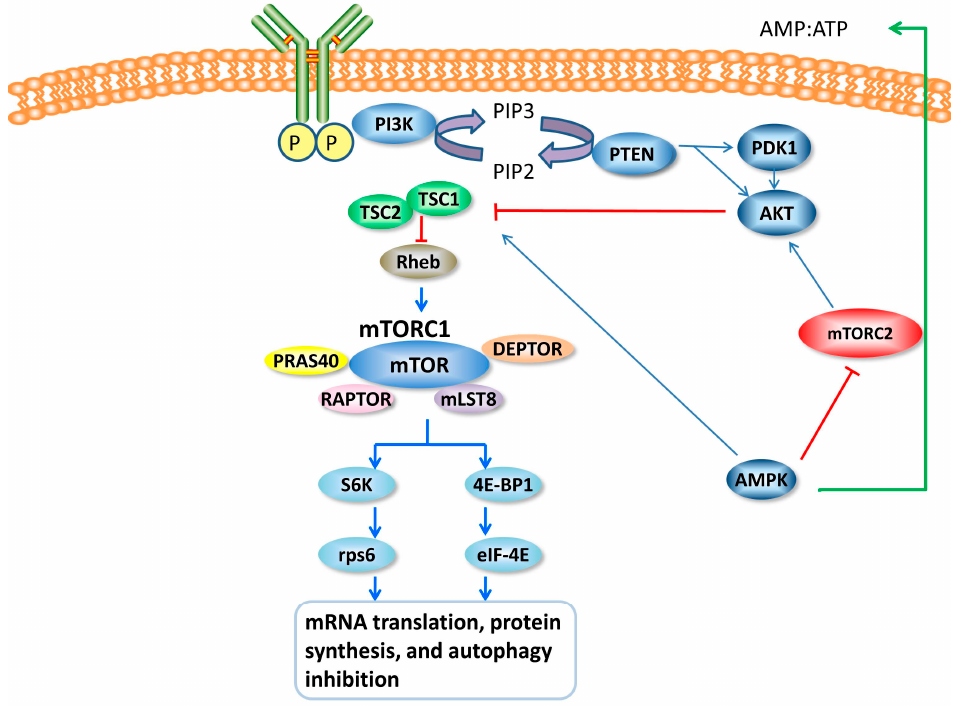
Figure 2. Schematic representation of the mTOR signaling pathway. mTORC1 is activated by Rheb (Ras homolog enriched in brain); the two most well-known downstream targets of mTORC1 are S6K1 (S6 kinase 1) and 4EBP1 (eukaryotic translation initiation factor 4E-binding protein 1). As an upstream signal, TSC (tuberous sclerosis complex) can suppress Rheb to negatively regulate mTORC1. Furthermore, PTEN (phosphatase and tensin homolog deleted on chromosome 10) can be suppressed by PI3K (phosphoinositide 3-kinase), thus inactivating the mTOR pathway. In addition, AMPK (AMP-dependent kinase) is activated by a high AMP/ATP ratio and suppresses mTOR. The main function of mTORC1 activity is the stimulation of mRNA translation, protein synthesis, and autophagy inhibition. PIP2/PIP3, Phosphatidylinositol 4,5-bisphosphate/Phosphatidylinositol 3,4,5-triphosphate; PDK1, 3-Phosphoinositide-dependent protein kinase 1; AKT1, AKT serine/threonine kinase 1; PRAS40, 40 kDa pro-rich AKT1 substrate 1; RAPTOR, regulatory associated protein of mTOR; mLST8, mammalian lethal with SEC13 protein 8; DEPTOR, DEP domain-containing mTOR-interacting protein.